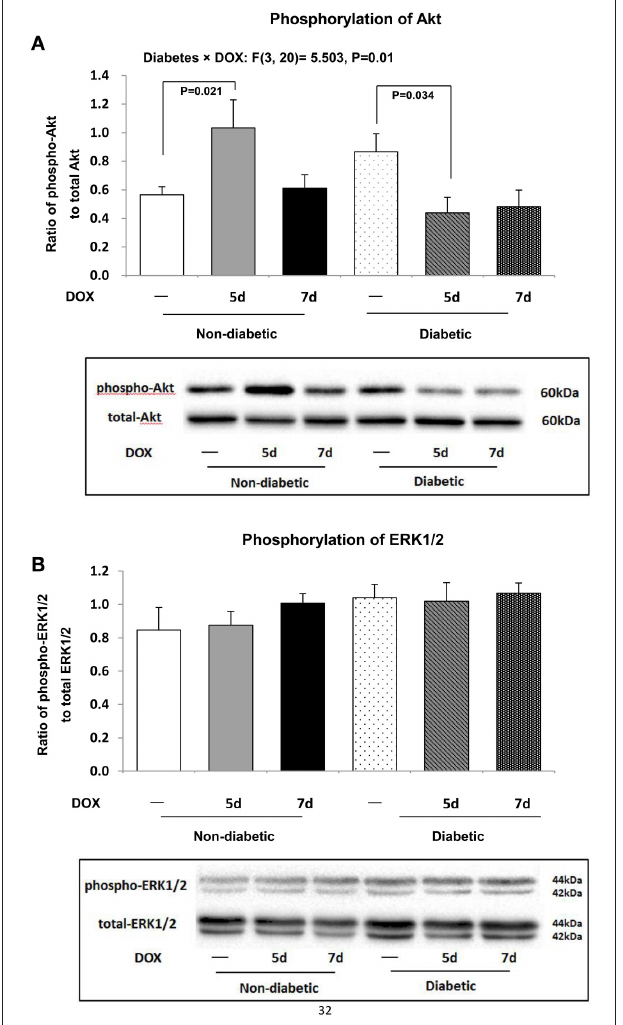
FIGURE 5 | Myocardial pro-survival cellular signaling. Activation of Akt and ERK1/2 signaling was determined by examining their phosphorylation statuses. Protein abundances of phospho-Akt, total Akt, phospho-ERK1/2, total ERK1/2 were measured by Western blot analysis. Phospho-Akt-to-total Akt (A) , and phospho-ERK1/2-to-total ERK1/2 (B) were shown. Data are expressed as mean ± SEM. According to our two-way ANOVA results, a